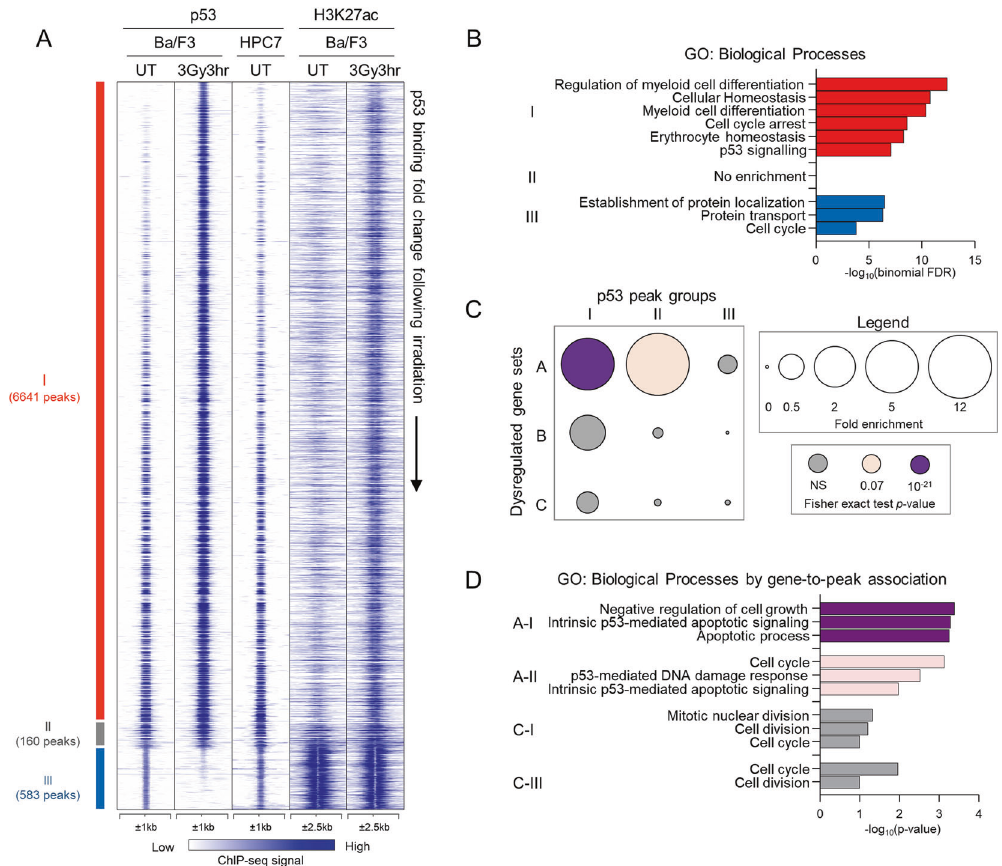
Fig. 2 Mapping the genome-wide p53 DNA-binding sites and p53-regulated genes in murine HSPCs in response to whole-body irradiation. A Heatmap displays 7384 p53 DNA-binding sites, or peaks, identi fi ed from p53 ChIP-Seq in Ba/F3 and HPC7 hematopoietic progenitor cells, with and without irradiation (3 Gy, 3 h). The peaks are ordered based on fold changes in p53-binding intensity following irradiation (IR) and organized into three groups. Group I is composed of peaks with ≥ 1.5 fold increase in p53 binding following IR, Group II is composed of peaks with minimal change in p53 binding (FC ≤ | 1.5 | ), and Group III is composed of peaks with ≥ 1.5 fold decrease in p53 binding following IR. For the p53 ChIP-Seq, binding intensities ±1 kb around the p53 peak centers are plotted. For the histone H3K27ac ChIP- Seq, binding intensities ±2.5 kb around the p53 peak centers are plotted. H3K27ac ChIP-Seq in Ba/F3 cells was previously described [32]. B Gene ontology analysis of genes nearest to p53 peaks, performed using GREAT [37] with basal plus extension option and searching for genes 2 kb upstream, 2 kb downstream, and 200 kb in distal to each p53 peak. The − log10(binomial FDR) values are plotted for each GO term. C Association of RNA-Seq and ChIP-Seq data shows dysregulated genes having p53 peaks within 10 kb. The circle size represents fold enrichment of dysregulated genes in the gene-to-peak association compared to random gene sets. The color represents the signi fi cance of the fold enrichment, calculated by two-tailed Fisher exact test. The random gene sets consist of 10 sets of 200 genes randomly selected from the total 13,753 expressed genes identi fi ed by RNA-Seq. NS not signi fi cant. D Gene ontology analysis of putative p53-target genes identi fi ed as genes showing p53-dependent dysregulation in RNA-Seq data and having p53-binding peaks within 10 kb. The top biological process terms are displayed, and − log10( p values) are